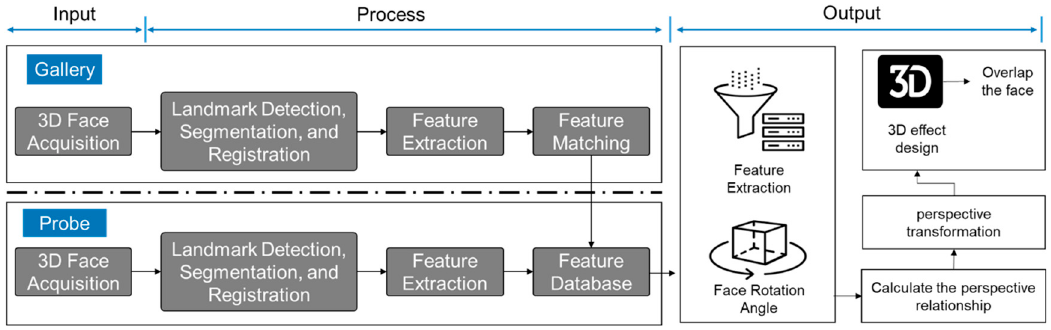
Figure 3. A 3D facial recognition of augmented reality system.